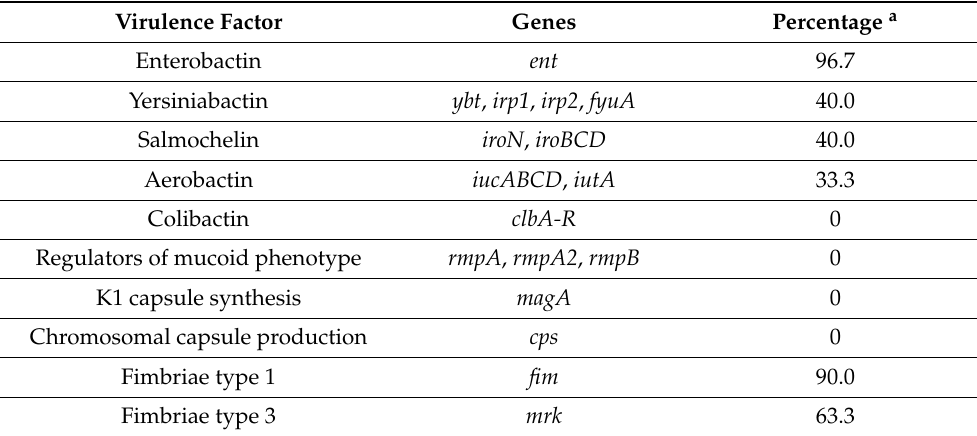
Table 3. Virulence factors detected in carbapenem-resistant Klebsiella spp. isolates recovered from municipal WWTPs and their receiving water bodies as well as from process waters of poultry and pig